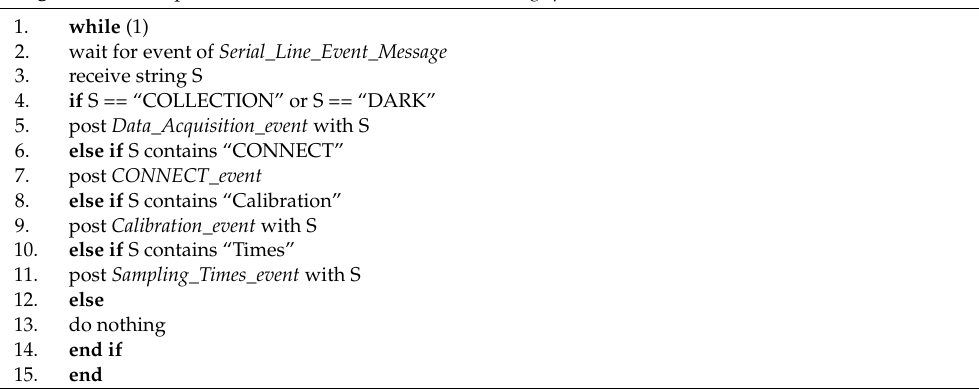
Algorithm 2: The pseudo code of the Receives_Serial_Message process